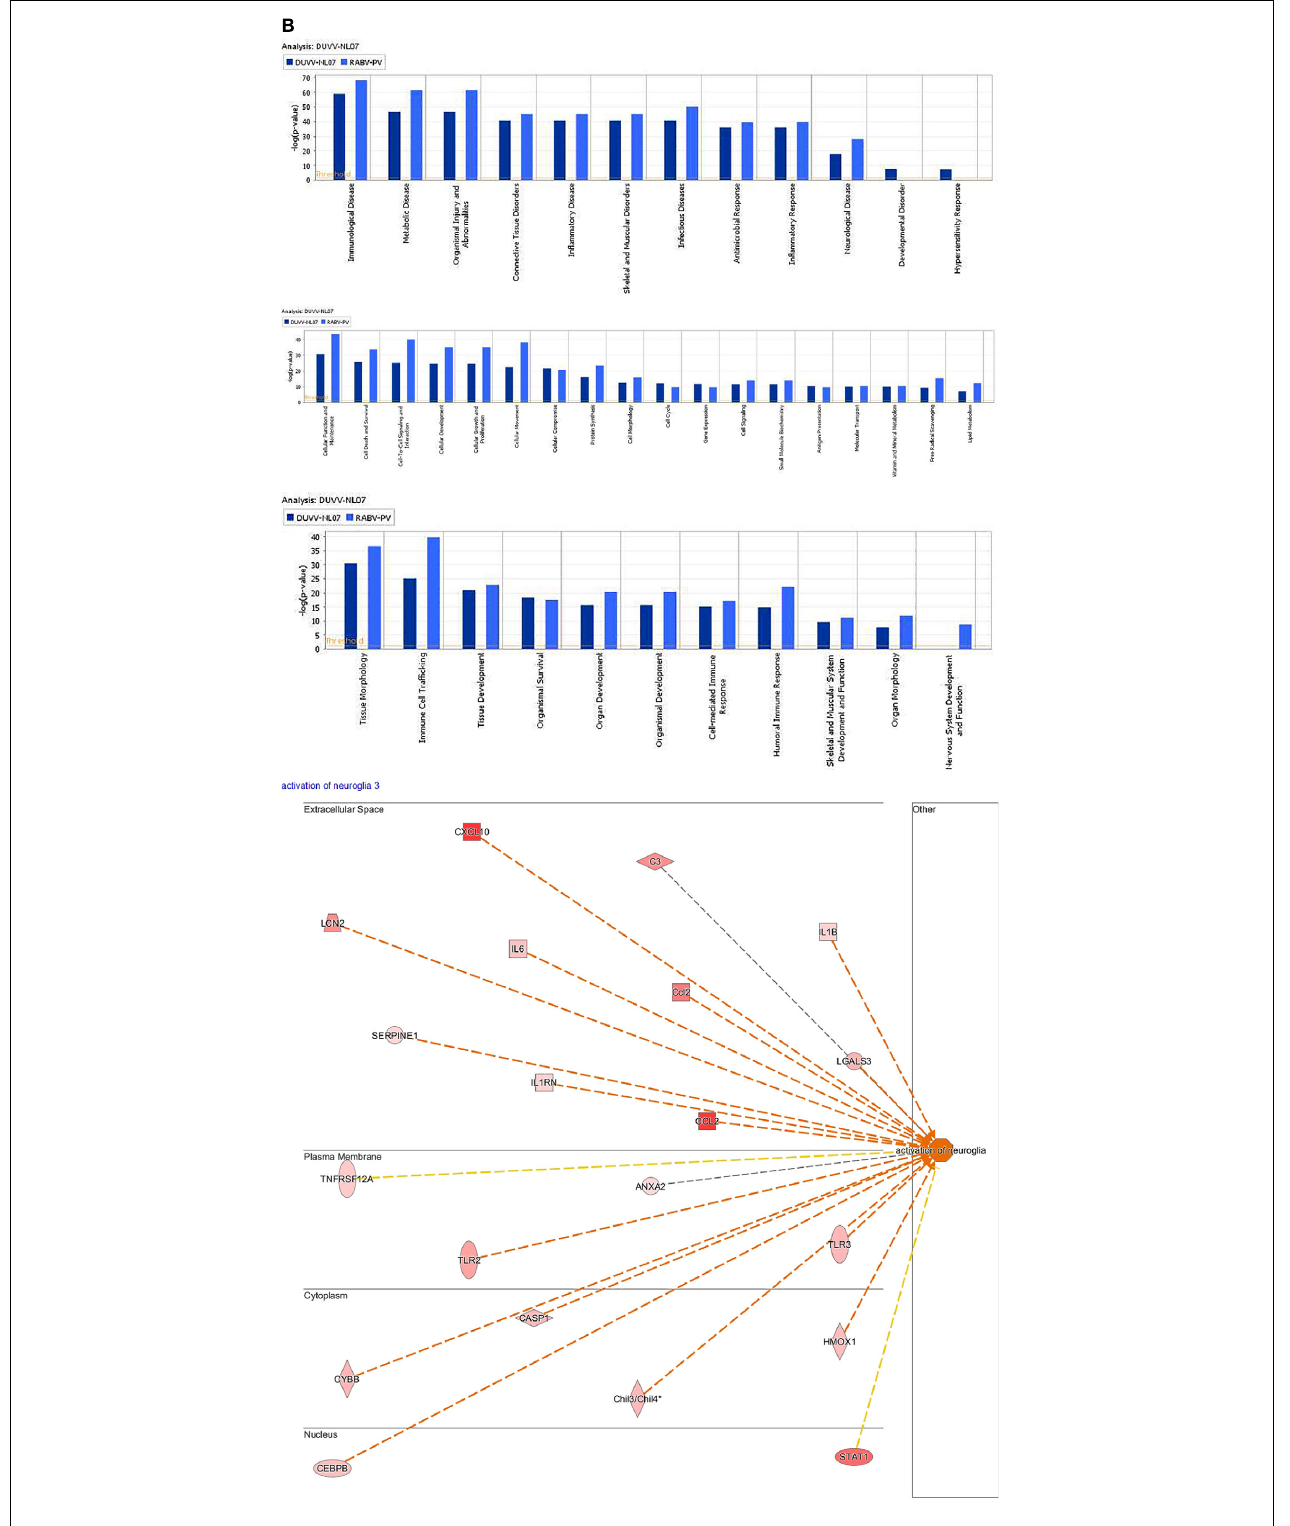
FIGURE 3 | (A) Top canonical pathways identified by IPA. Picture depicts the comparison between enriched pathways after DUVV-NL07 and RABV-PV infection of mice based on their p -value. (B) Implication of differentially expressed genes in diseases and disorders (upper panel), molecular and cellular functions (middle panel), and physiological development and function (lower panel) identified by IPA. Activation of neuroglia cells is depicted in the insert of the lower panel as an example of nervous system development and function.